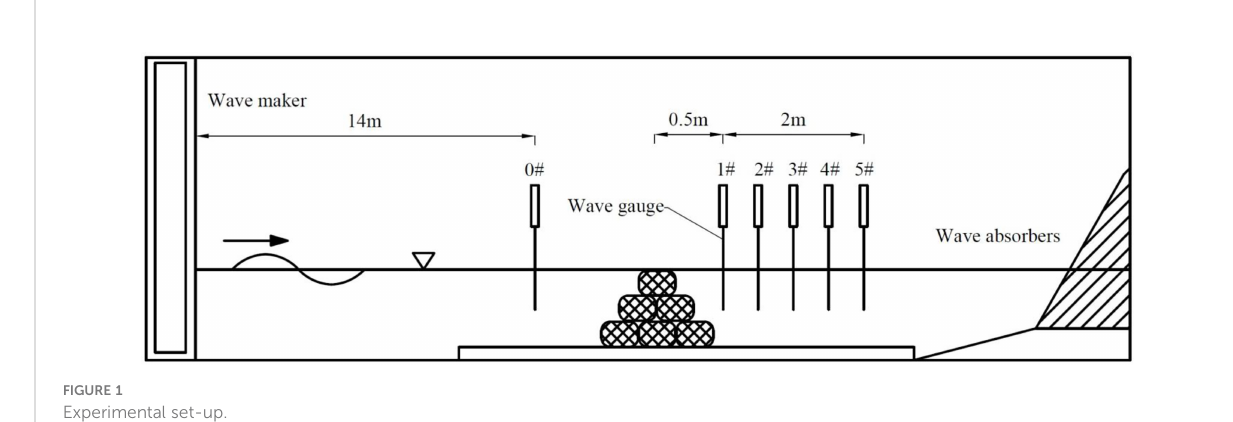
FIGURE 1 Experimental set-up.